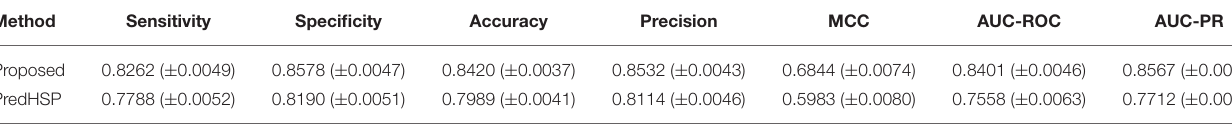
TABLE 3 | Performance metrics for the proposed approach with respect to classification of HSP and non-HSP sequences. Method